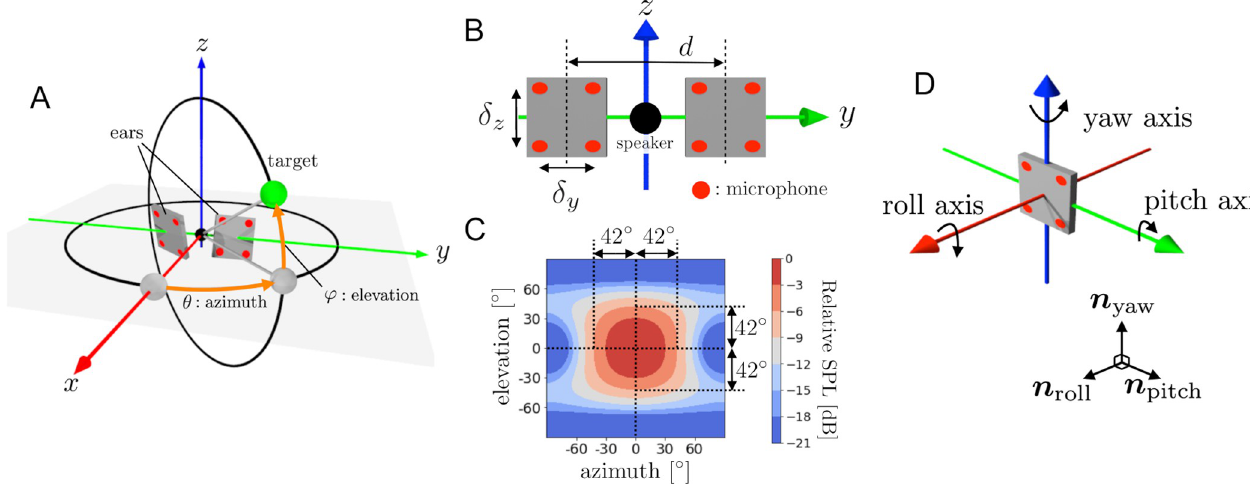
Fig 2. Schematic diagram of model setup. (A) Direction of the target (green ball) expressed by azimuth angle θ and elevation angle φ . (B) Positions of the two directional ears with spacing d . Each red dot indicates the position of an omni-directional microphone. Each ear consists of four omni-directional microphones, where δ and δ are the horizontal and vertical spacings of each microphone. (C) Hearing directivity pattern of the virtual ear. (D) Three axes y z (roll, pitch, yaw) fixed to the directional ear and corresponding orthonormal basis [ n roll , n pitch , n yaw ].